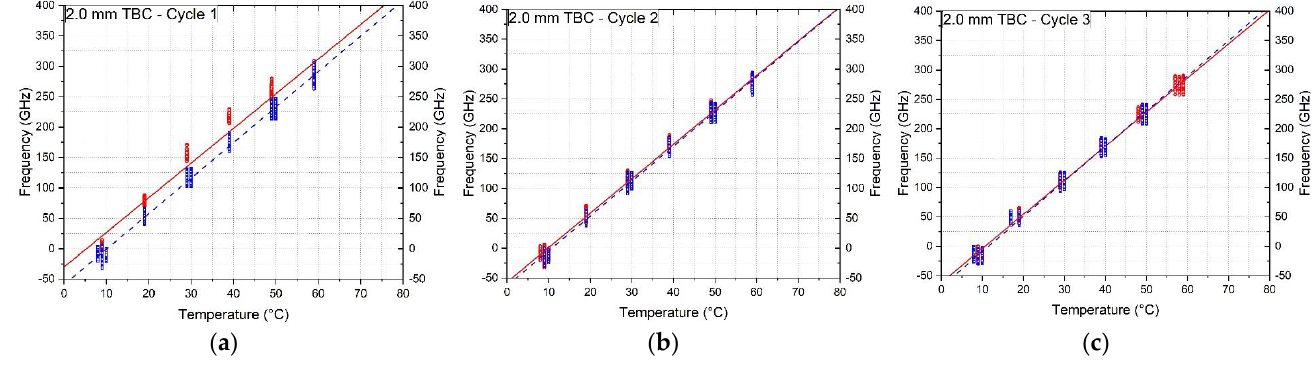
Figure 6. Heating and cooling calibration datapoints and linear fit of the 2.0 mm tight buffered cable with polyurethane coating, ( a ) first cycle, ( b ) second cycle and ( c ) third temperature cycle. Table 4. Temperature calibration factors for tight-buffered and loose-tube cables.